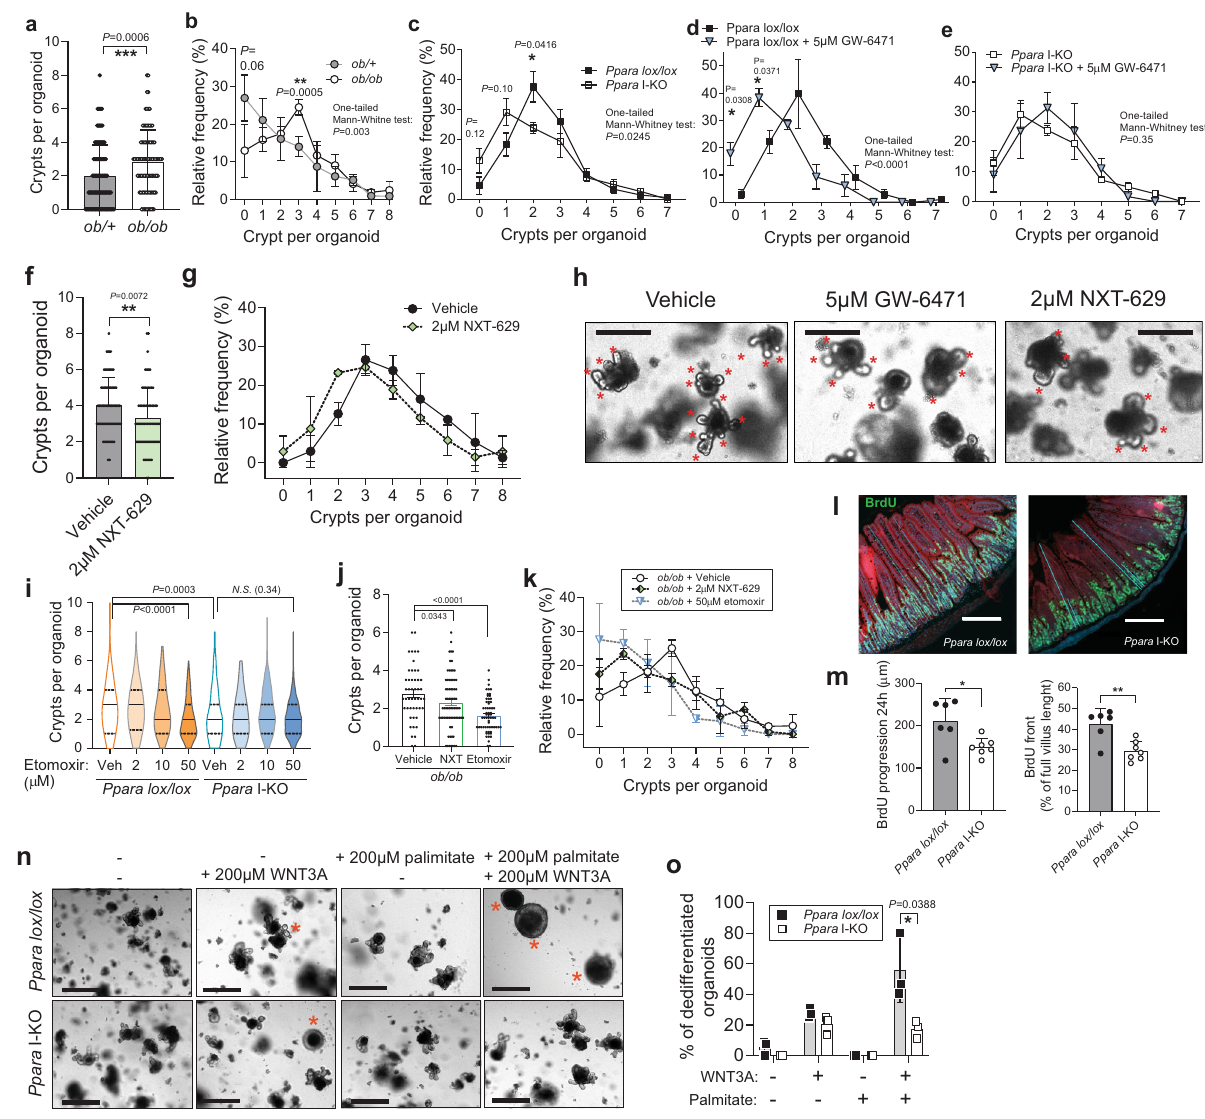
Fig. 4 Organoid crypt budding is decreased by PPAR α knock-out and inhibition. a Number of crypts per organoid in the organoid cultures derived from two ob/ + and two ob/ob mice on chow diet. 120 ob/ + and 88 ob/ob organoids were analysed from 3 wells per group, at day 5, one-tail Mann – Whitney test. b Histogram of ( a ) n = 3 wells per group. c Histogram of organoid distribution according to the number of crypts in the cultures from Ppara lox/lox and I-KO mice on chow diet, cultured without inhibitors, pool from two independent experiments and 6 ( lox/lox ) or 5 (I-KO) wells per group, total of 282 ( lox/ lox ) or 220 (I-KO) organoids. One-tail Mann – Whitney tests on the histograms refer to the comparison of all organoids between the two groups (as in a ), and asterisks for difference (two-tailed t-test) between frequencies of distribution on the histograms. d , e Histogram of organoid distribution by the number of crypts in the cultures from Ppara lox/lox , n = 3 wells per group ( d ) or Ppara I-KO mice ( n = 5 wells for DMSO, n = 3 for GW-6471) ( e ), treated daily with DMSO or 5 μ M GW-6471, on day 7. f Number of crypts per organoid, on day 9 of daily incubation with 2 μ M NXT-629 and its vehicle, from two mice per group, 72 (vehicle) and 69 (NXT-629) organoids analysed, one-tail Mann – Whitney test. g Histogram of ( f ). h Representative images of organoid cultures from ( d ) and ( f ) on day 9, red asterisks mark crypt outgrowth, scale bar is 200 μ m. i Violin plot of distribution of organoids per number of crypts in Ppara lox/lox and Ppara I-KO organoids when incubated with etomoxir, pooled from three wells per group on day 5 in a single experiment, median marked with solid, quartiles with dashed lines. Number of organoid, lox/lox: 251 (vehicle), 84 (2 μ M), 169 (10 μ M), 162 (50 μ M), I-KO: 193 (veh.), 87 (2 μ M), 270 (10 μ M), 202 (50 μ M) j, Number of crypts per organoid from ob/ob mice as in ( a ), on day 5 of daily incubation with a vehicle or 2 μ M NXT-629, n = 88 (veh.), 127 (NXT), n = 201 (etomoxir). k Histogram of ( j ). l , m BrdU staining of jejunum 24 h after injection, with villi counterstained with Evans blue, and thin blue lines indicated measurements of villi and BrdU progression, scale bar is 200 μ m ( l ), BrdU progression along the villi in μ m, and as a percentage of villus length ( m ), n = 6 ( lox/lox ), 7 (I-KO) mice per group. n Addition of WNT3A to basal ENR medium (EGF, Noggin, R-spondin) induces cystic crypts and organoids (red asterisks), potentiated by addition of palmitate, scale bar is 500 μ m. o Percentage of spherical organoids in the well, n = 3 per group, day 7. All data represent mean ± S.D, (except for I , as described) * P ≤ 0.05, ** P < 0.01, *** P < 0.001 of unpaired two-sided t -test, con fi dence level 95%, except for ( a , f , and i ), where it stands for one-tail Mann – Whitney non-parametric test. Source data are provided as a Source Data fi